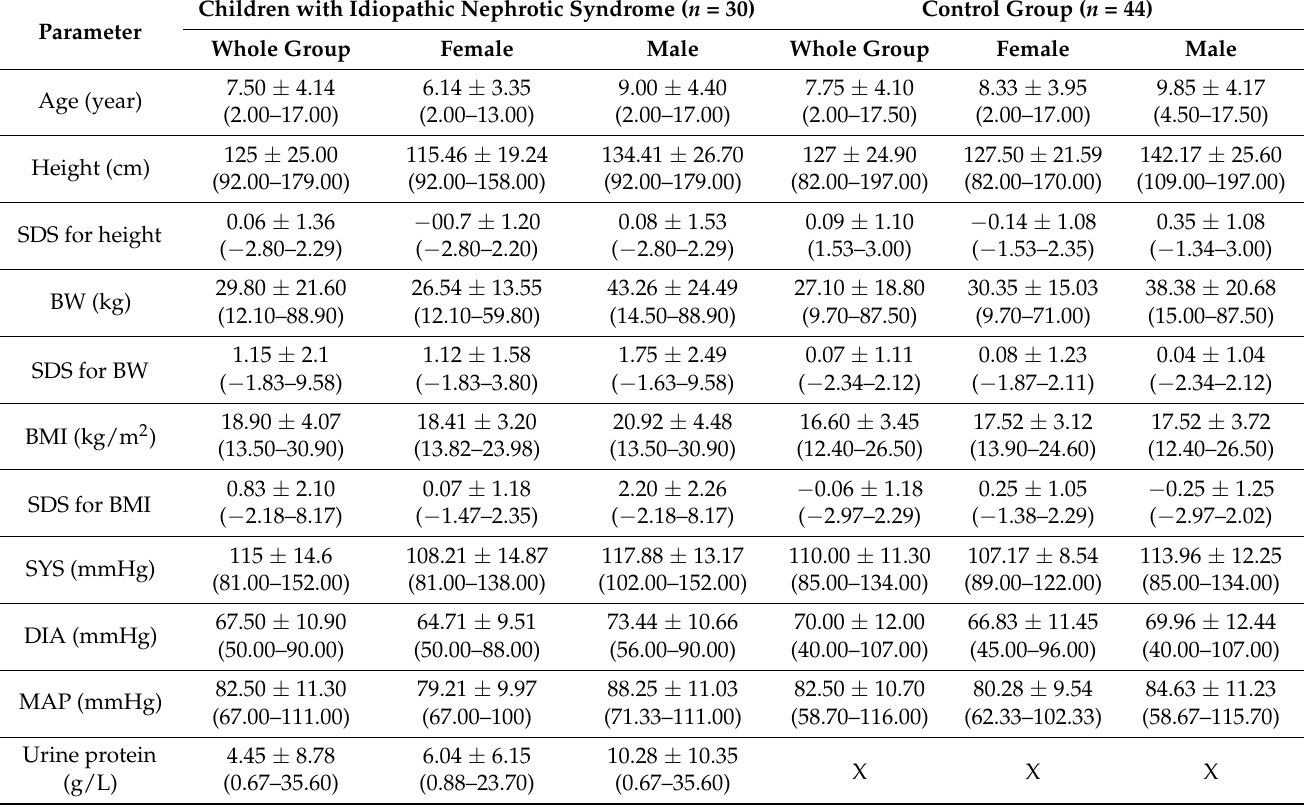
Table 1. Characteristics of the groups—selected anthropometric and laboratory